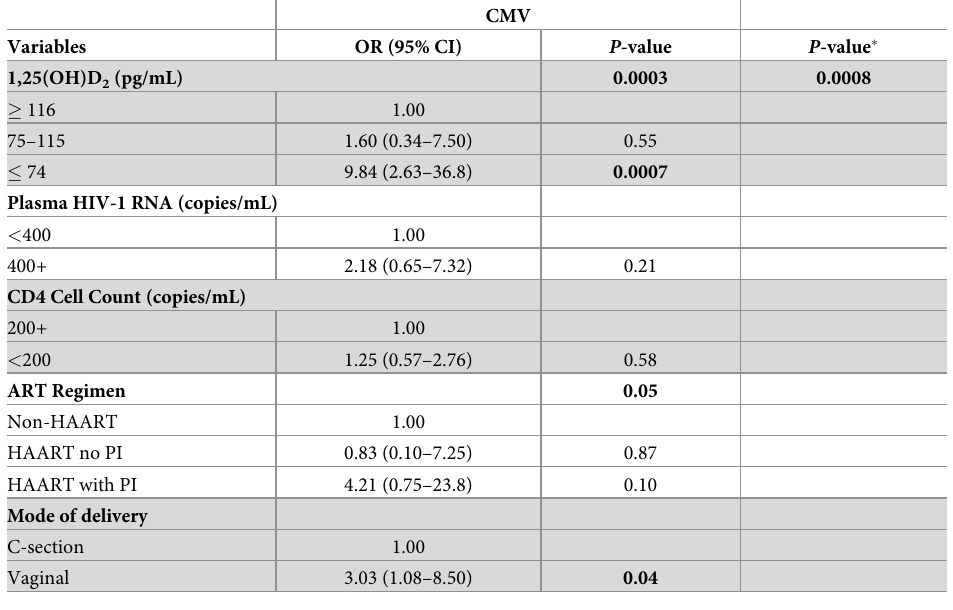
Table 6. Factors associated with peri/postnatal CMV in multivariate